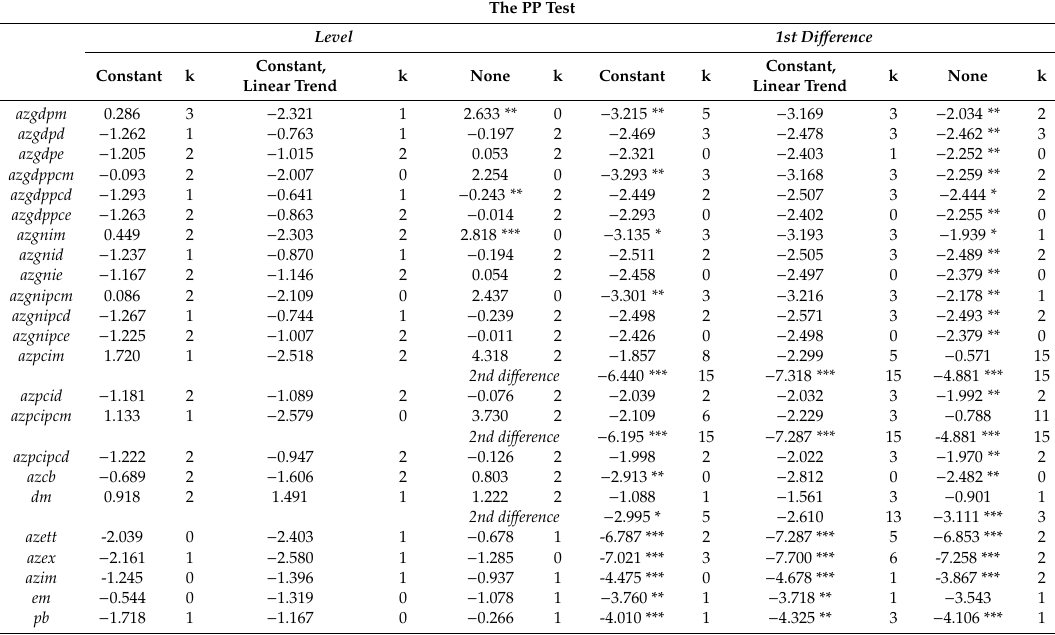
Table A15. AZ. The Unit Root test